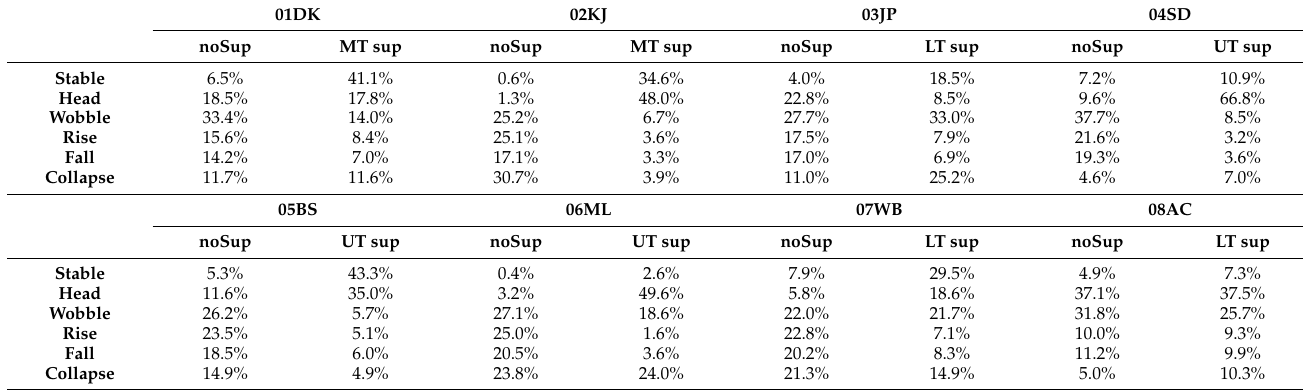
Table 4. Percentages of each behavior type for each participant for both conditions. noSup = No Support, which means pelvic stability strap and manual assistance at pelvis, if necessary. MT sup = mid thoracic support, UT sup = upper thoracic support, and LT sup = lower thoracic